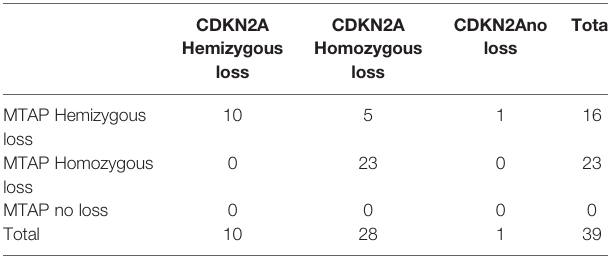
TABLE 7 | Comparison of droplet digital PCR (ddPCR) results for detecting methylthioadenosine phosphorylase (MTAP) and CDKN2A deletion in malignant pleural mesothelioma (MPM)